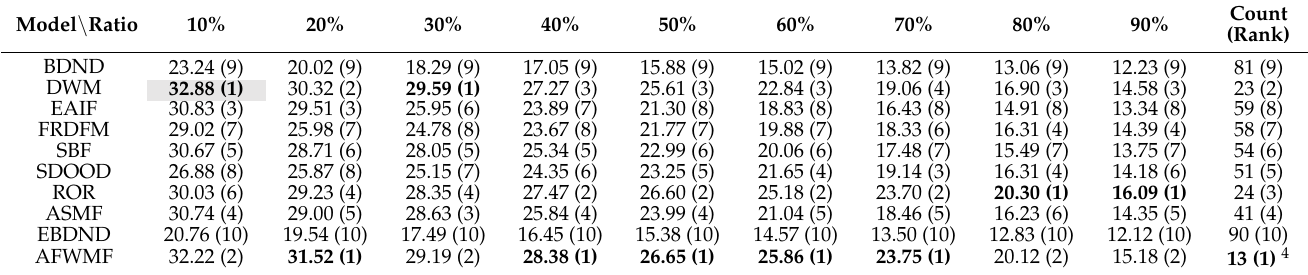
Table 4. The PSNR average value at different noise densities from different filters for the five experimental images. Model \ Ratio